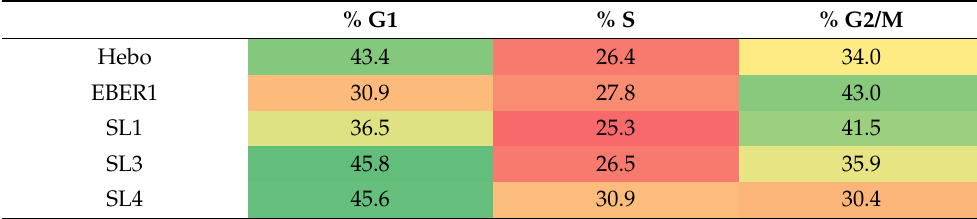
Table 1. Percentage distribution of DNA contents across the cell cycle . The percentage distribution of DNA contents in the cell cycle phases (G0/G1, S, and G2/M) was analysed using FlowJo. Experi- ments were performed in duplicate and repeated four times. The data are presented as mean of the four independent experiments. The table is colour formatted from red (lower percentage) through green (higher percentage).